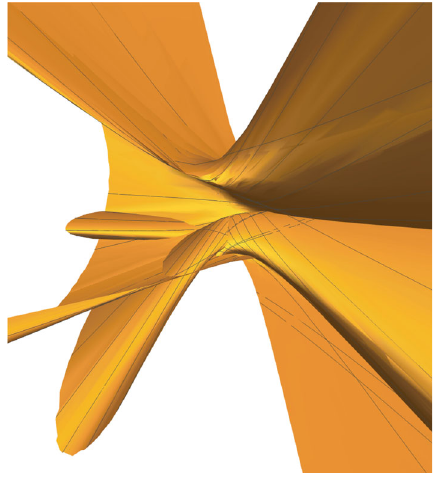
B -Darboux frame. 2 via